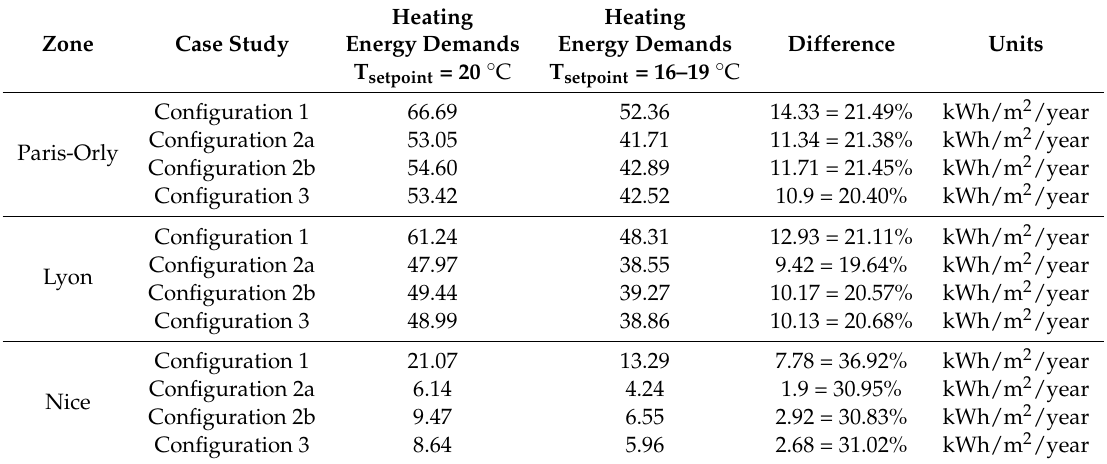
Table 10. Ratio of the difference in annual heating energy demands depending on constant vs. reduced setpoint temperatures, as well as on the various configurations and climatic conditions.